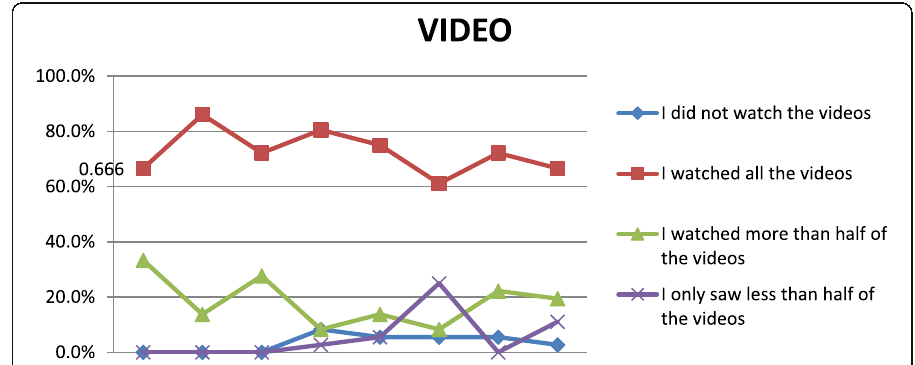
Fig. 4 The results of frequency of watching micro-lectures (videos). The abscissa indicates the number of times students are required to participate in viewing videos, and the ordinate indicates the completion rate of students watching videos. In the figure, the number of students who complete the video each time is much higher than the number of students who have not completed watching the